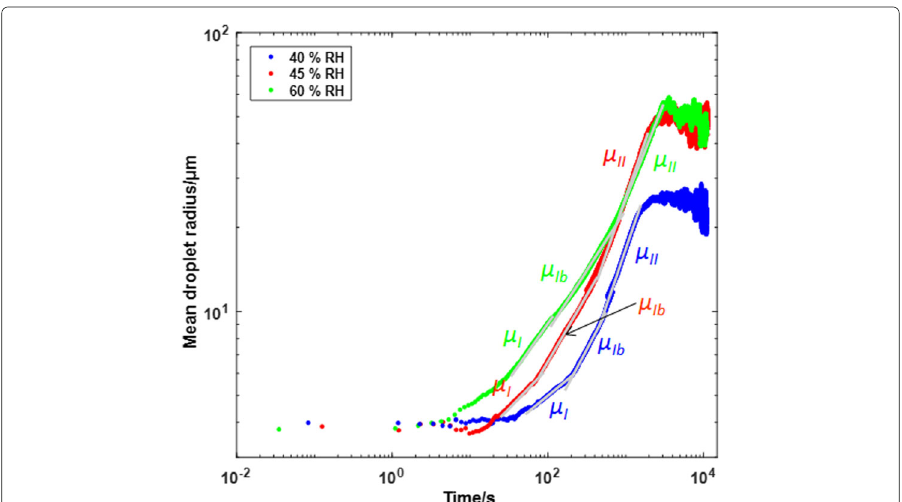
Fig. 8 Mean droplet radius as a function of time for the 40%, 45% and 60% relative humidity. 0, I, I b , II and III correspond to the different phases of the curves